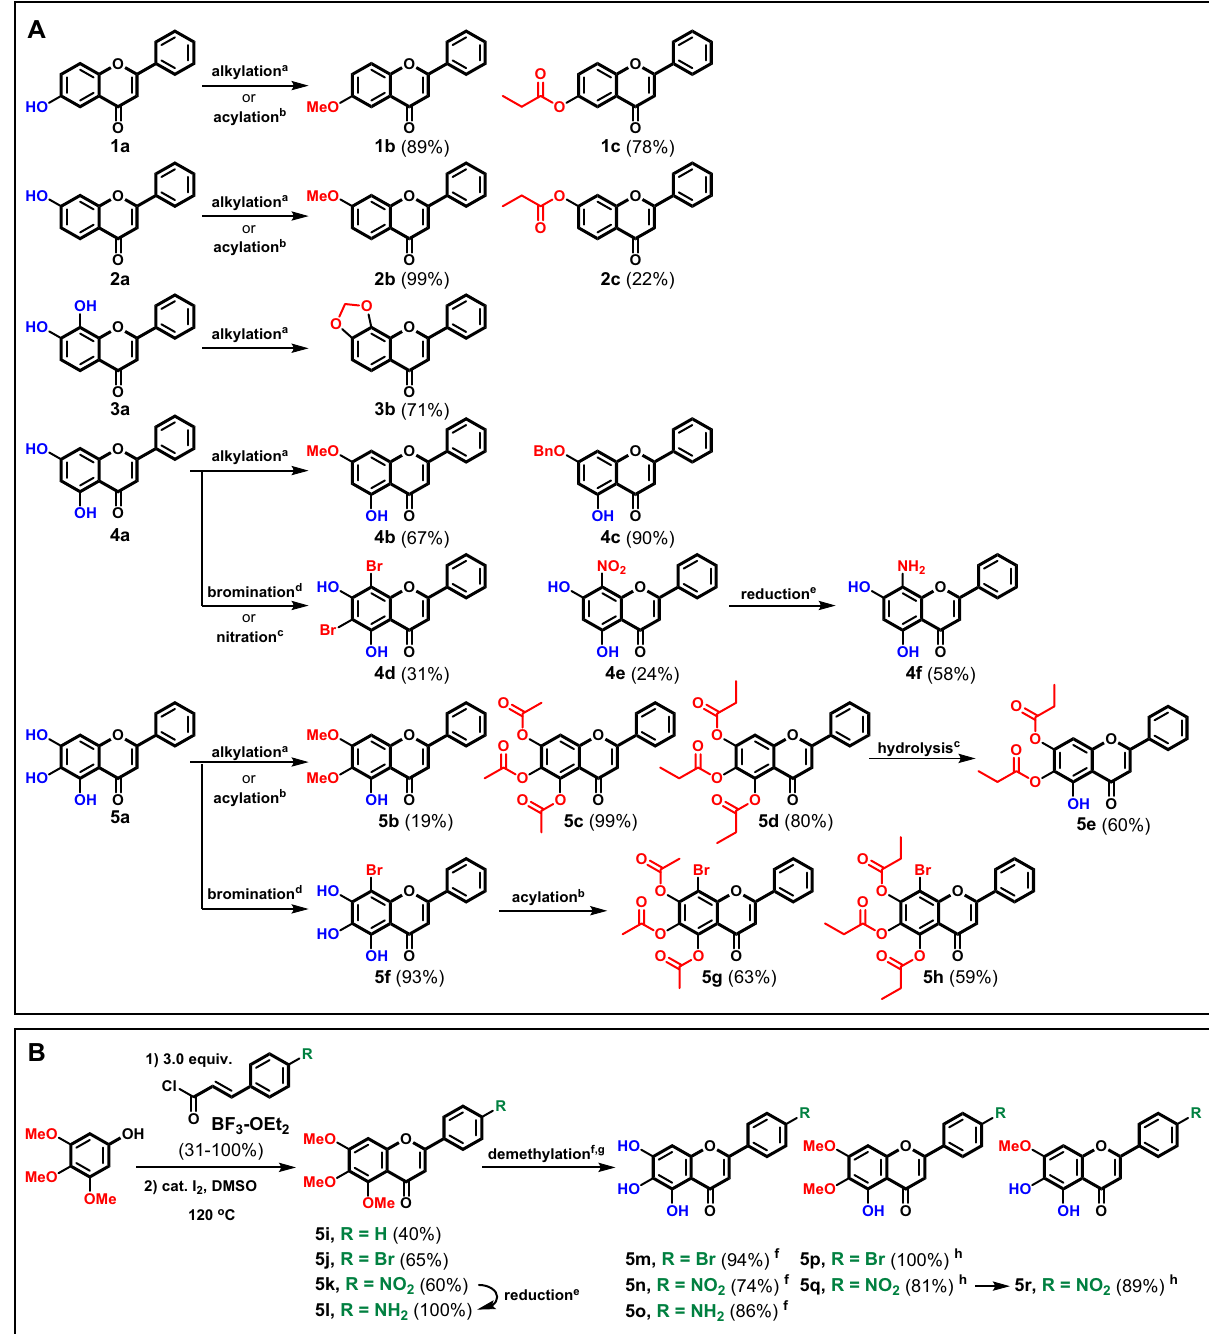
Figure 2. ( A ) Preparation of flavone analogs via semi-synthessis approach and ( B ) preparation of flavone analogs via total synthesis approach; a alkyl halide (1.5–5.0 equiv.), K 2 CO 3 (2.0–5.0 equiv.), acetone or DMF, 60–100 °C; b acyl anhydride (30 equiv.), pyridine, rt; c HNO 3 (1.0–2.25 equiv.), AcOH, 60 °C; d NBS (1.1–4.0 equiv.), THF, rt–60 °C; e Sn (5.0–10.0 equiv.) 12 M HCl, EtOH; f BBr 3 (3.0 equiv), CH 2 Cl 2 , g AlCl 3 (5.0 equiv), toluene, reflux; h 47% HBr, AcOH,